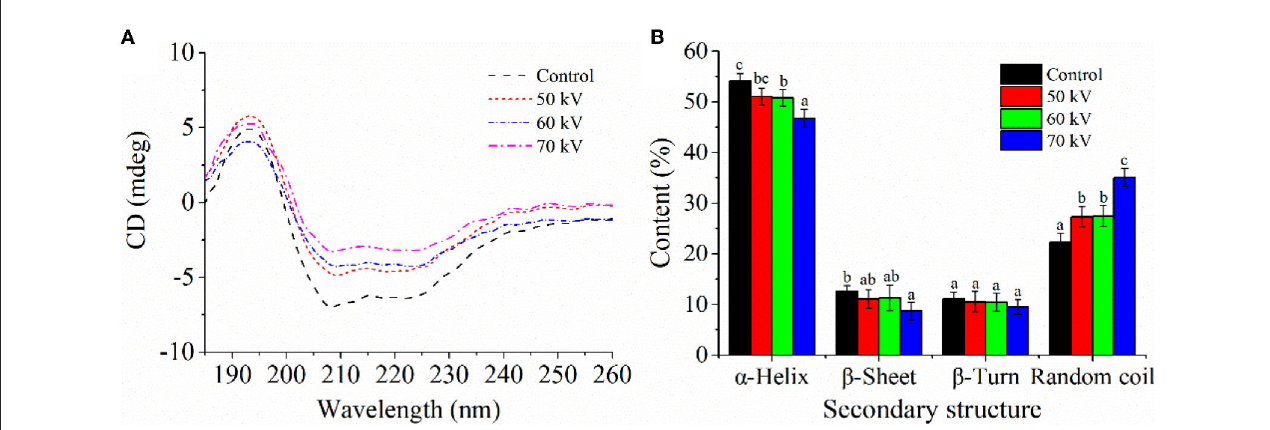
FIGURE4 Effect of DBD-CP on the secondary structure of myoglobin. (A) Circular dichroism (CD) spectra of Mb treated by different voltage. (B) The secondary structural changes of myoglobin were calculated from CD spectra; each sample was analyzed in triplicate; different small letters indicate significant differences ( p <